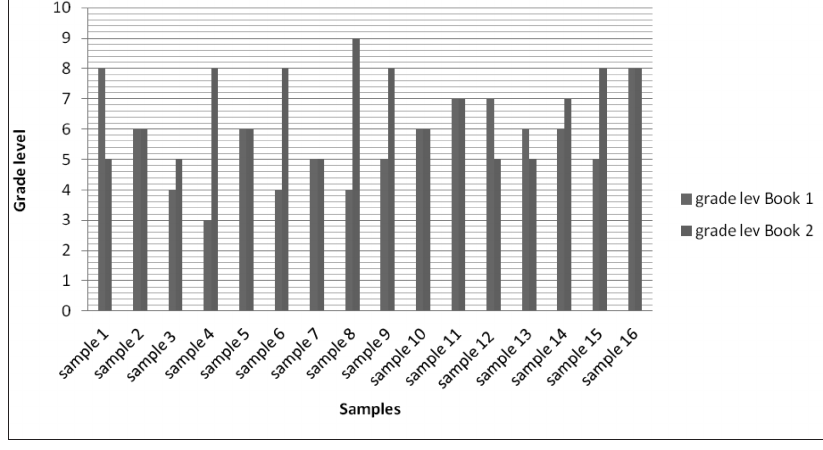
Table 4: Comparison of the measures of central tendency between the two books Mean Median Mode Book 1 6 6 6 Book 2 7 6.5